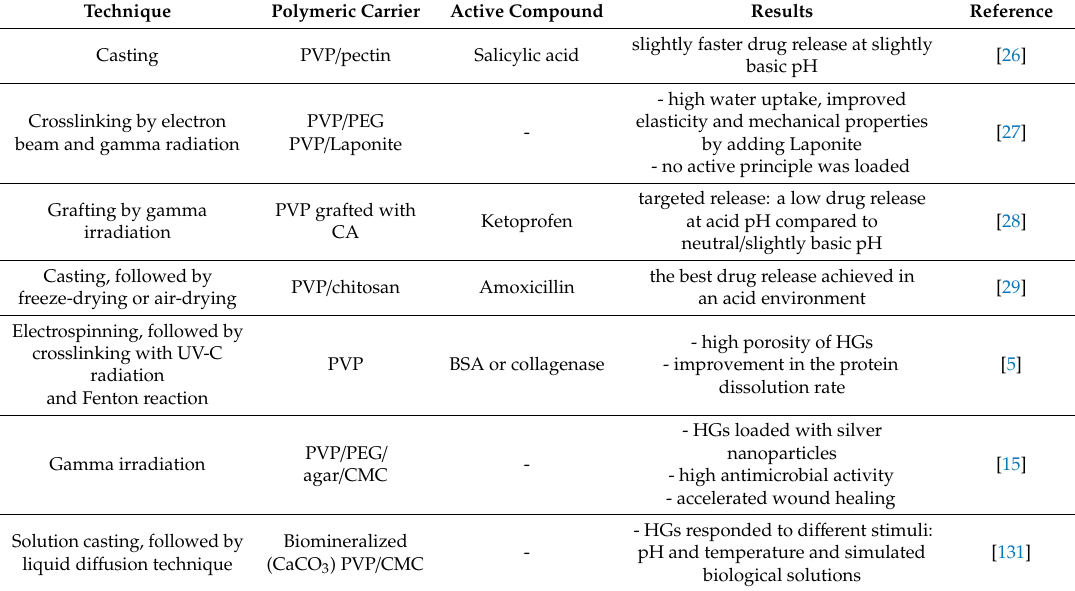
Table 3. PVP-based hydrogels. HGs, hydrogels; PEG, polyethylene glycol; CA, crotonic acid; BSA, bovine serum albumin; CMC, carboxymethyl cellulose.